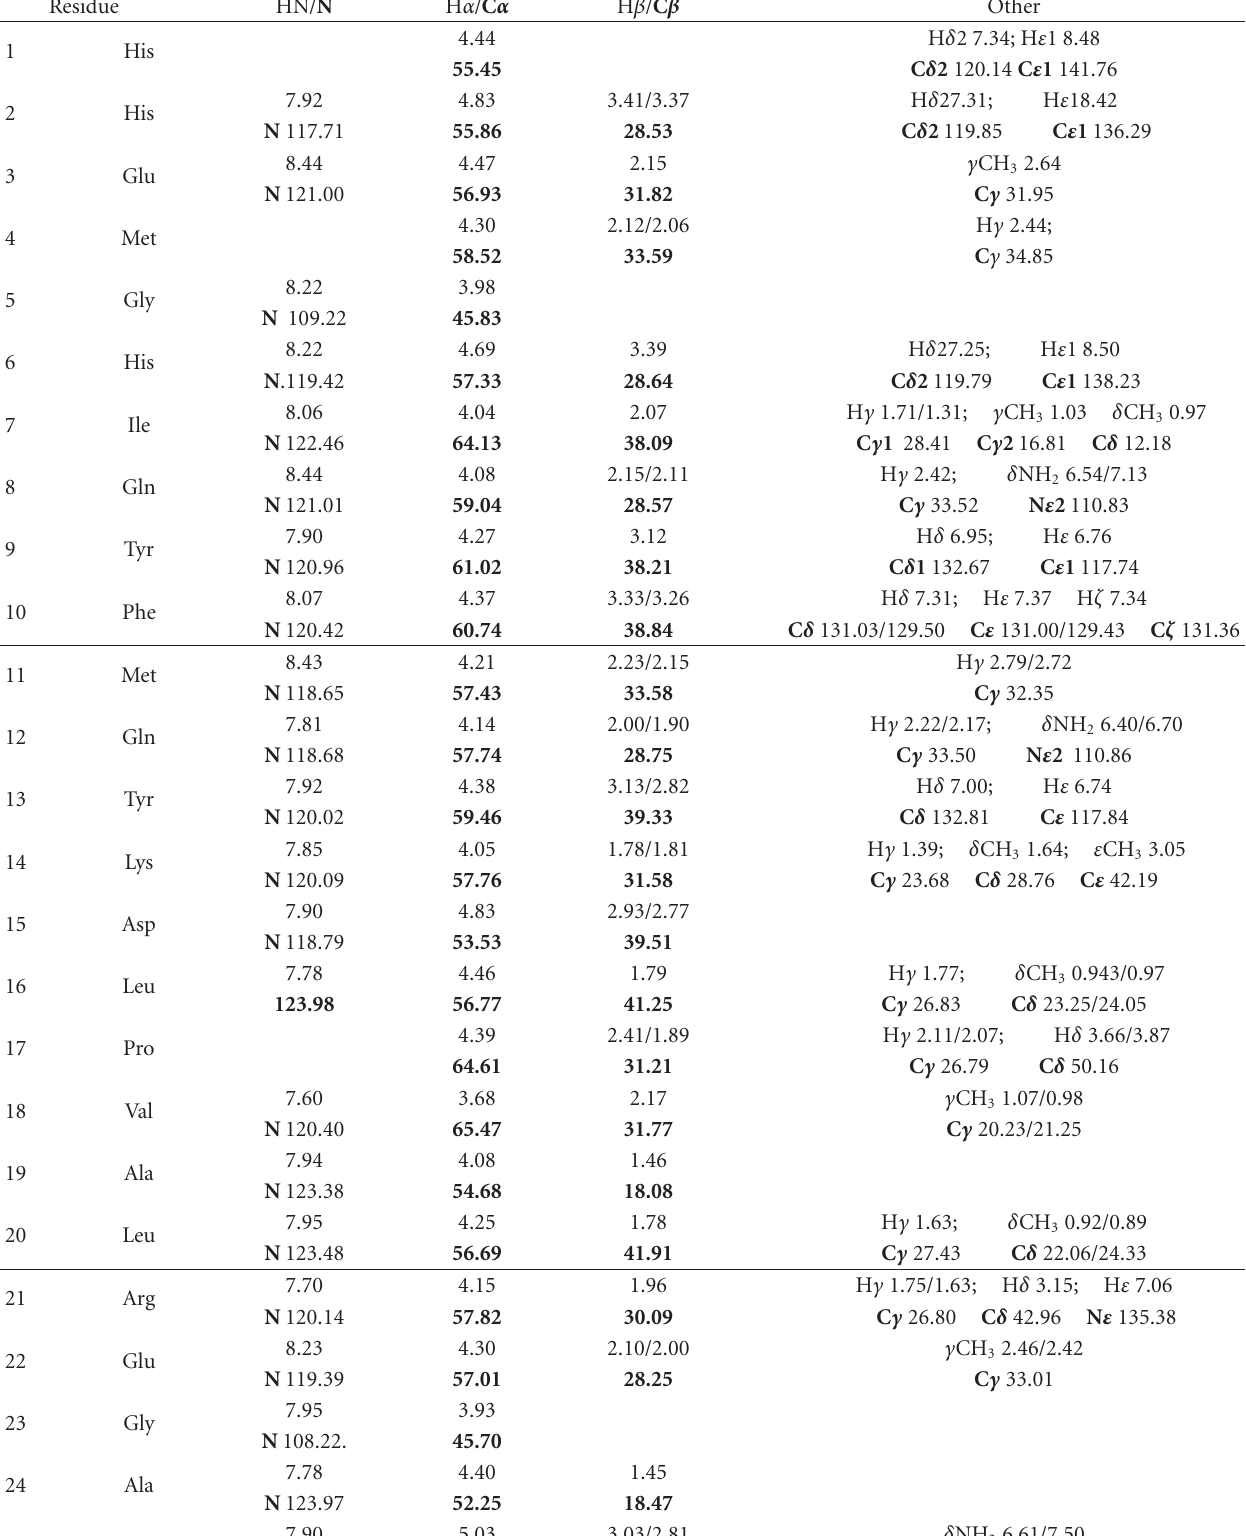
Table 2: 1 H, 15 N, and 13 C chemical shifts (ppm) of the residues in the Zn 2+ -ACE C (37) peptide at 298K (H 2 O/TFE- d2 34%/66% v/v. pH =